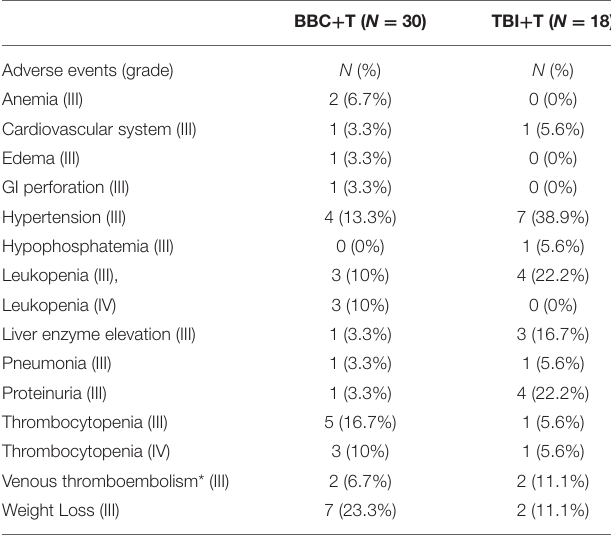
TABLE 2 | Occurrence of grade III or higher adverse events during chemotherapy